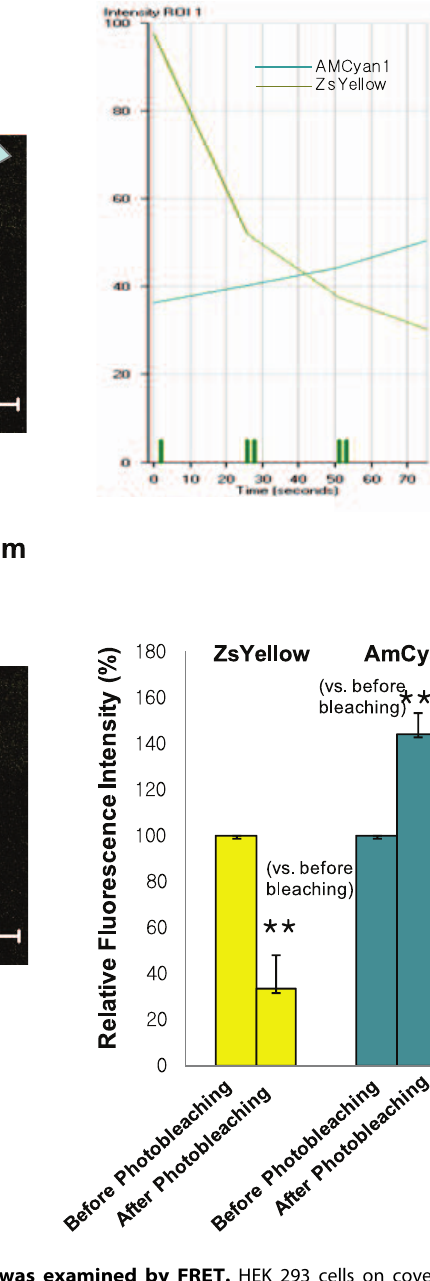
Figure 9. Molecular interaction between APP-BP1 and APP was examined by FRET. HEK 293 cells on coverlips in 6-well plates were transiently co-transfected with pZsYellow-APP-BP1 and pAMCyan1-APP. Figures in the left panel show representative results from the seven independent experiments. The right upper panel shows a representative graph indicating the time-lapse fluorescence changes in the region of interest (ROI). Green line: AMCyan1 fluorescence; gray: ZsYellow throughout the progression of successive bleaching marked as vertical green bars. In the right lower panel, relative fluorescence intensity is denoted after standardization of intensities before and after photobleaching of ZsYellow at 514 nm. * p , 0.05 versus fluorescence intensity before photobleaching of ZsYellow at 514 nm (by Student’s t-test). Scale bars=50 m m.